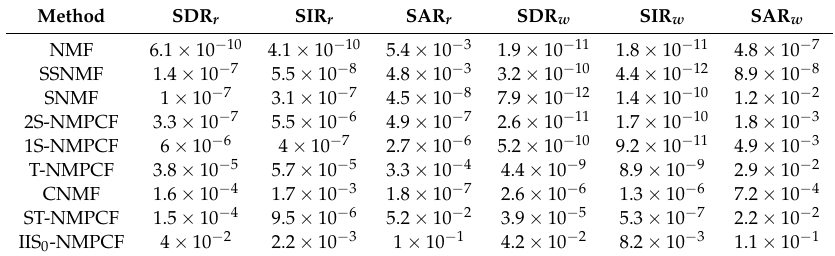
Each cell shows the parameter ρ that represents the probability of setting a statistically significant result. Considering a confidence interval of 95%, small values of ρ < 0.05 indicate that there exists statistical significance of the results